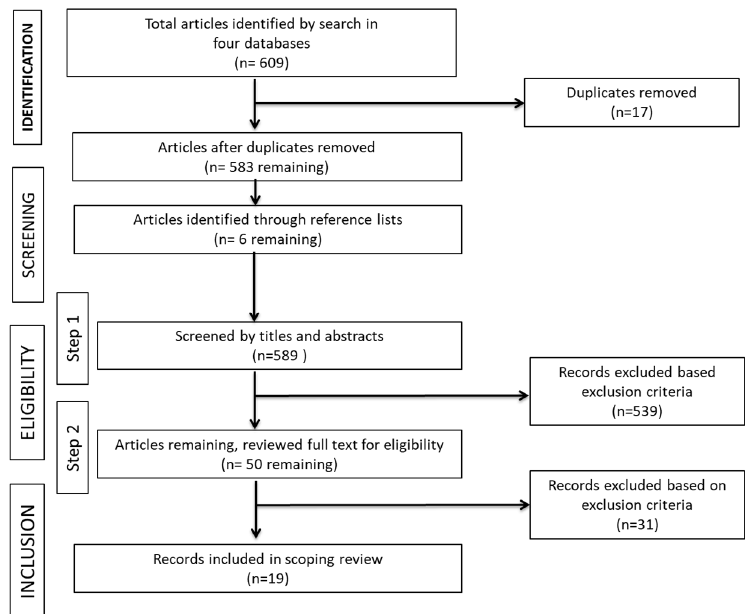
Figure 1. PRISMA flow diagram depicting the article selection process.